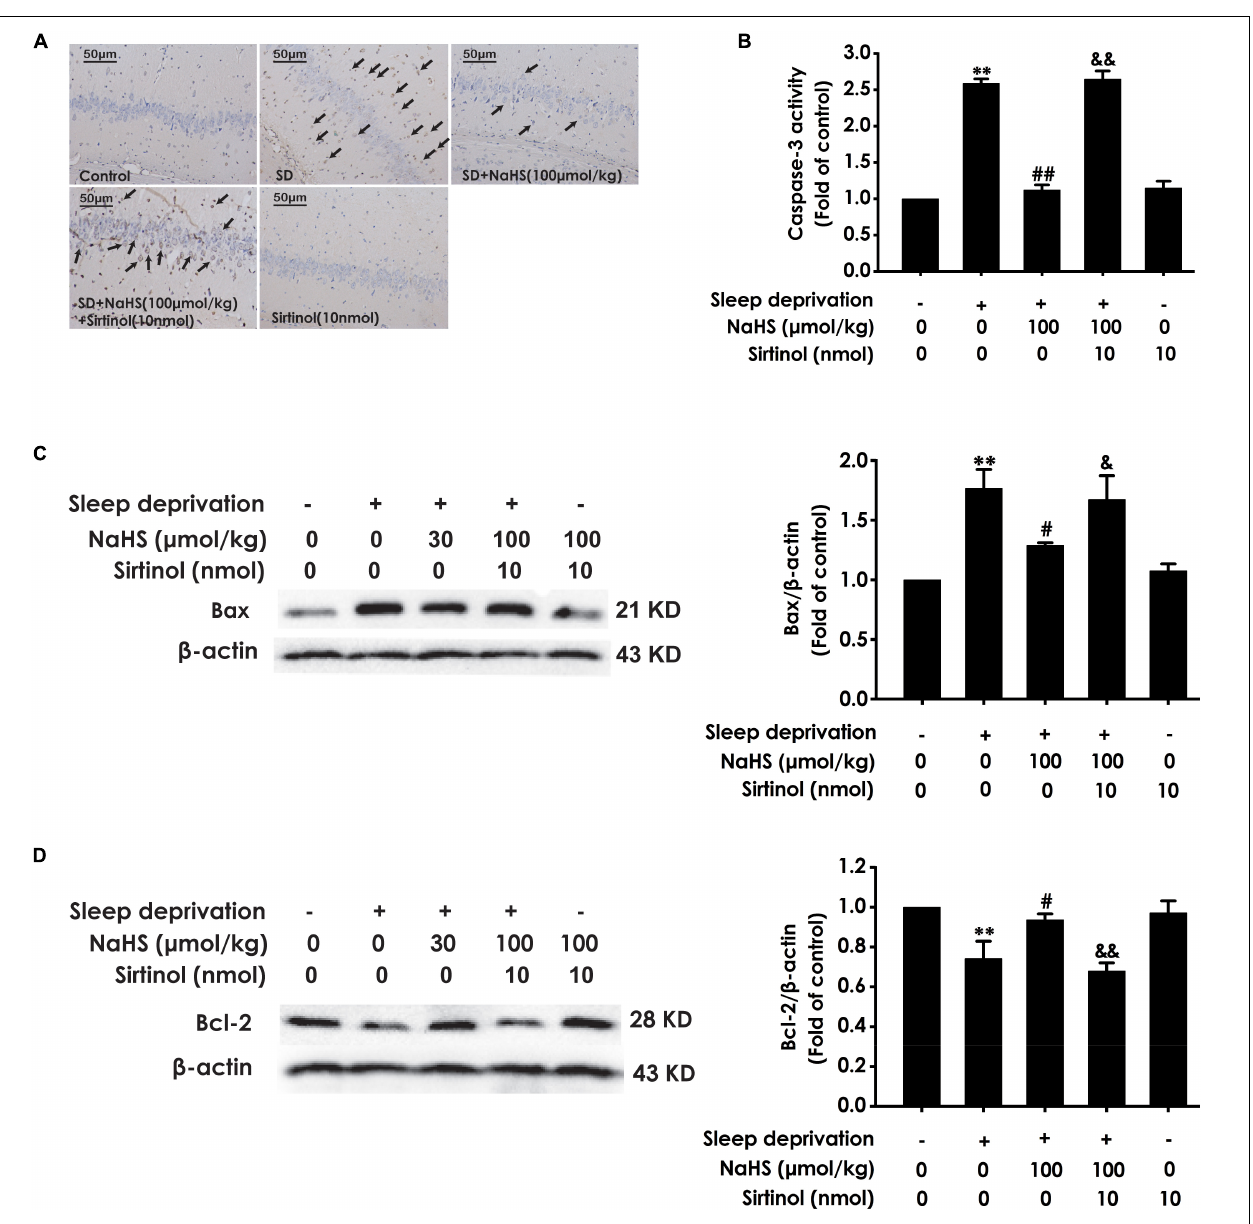
FIGURE 7 | Effect of Sirtinol on hydrogen sulfide ameliorated hippocampal apoptosis in sleep deprivation-induced rats. Rats were pretreated with NaHS (100 µ mol/kg/d, ip) for 7 days and then cotreated with SD and Sirtinol (10 nmol/d, icv) for 72 h. The apoptotic cells in the CA3 area of hippocampus (A) were assessed using Tunel staining and the arrow indicated the apoptotic cell. The activity of caspase-3 (B) in the hippocampus was detected by ELISA kits. The expressions of Bax (C) and Bcl-2 (D) in the hippocampus were measured by western blotting. In all blots, β -actin was used to determine control. Values are the mean ± S.E.M. ( n = 3). ∗∗ P < 0.01, vs. control group; # P < 0.05, ## P < 0.01, vs. SD-treated alone group; & P < 0.05, && P < 0.01, vs. cotreated with NaHS (100 µ mol/kg/d, i.p.) and SD treated